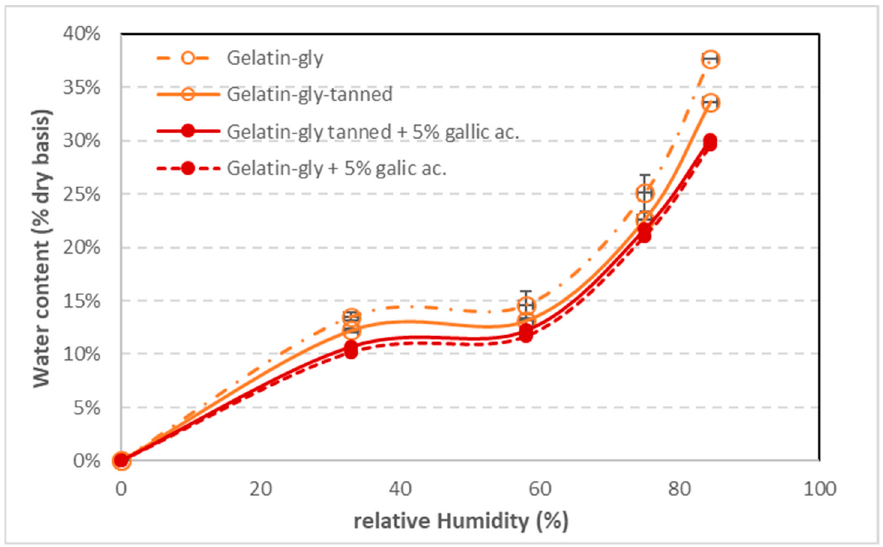
Figure 4. Moisture sorption isotherms of standalone coatings measured at 25 °C.